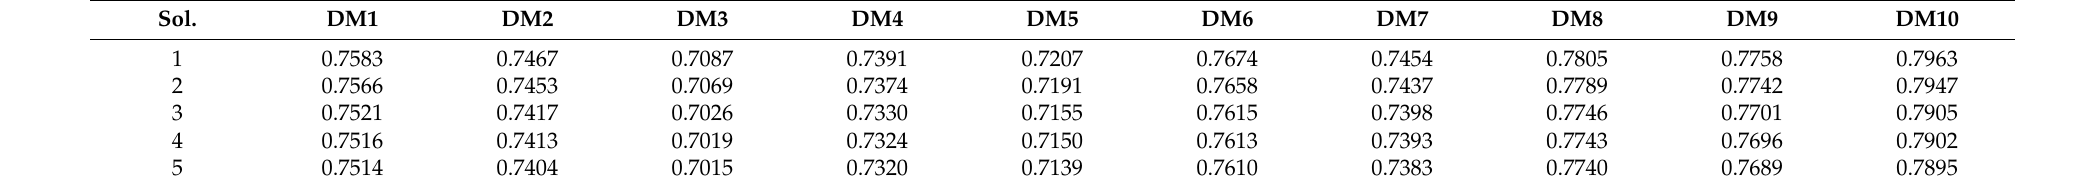
Table A8. Values of σ Pi ( Z Gki , B i ) for the solutions in Table